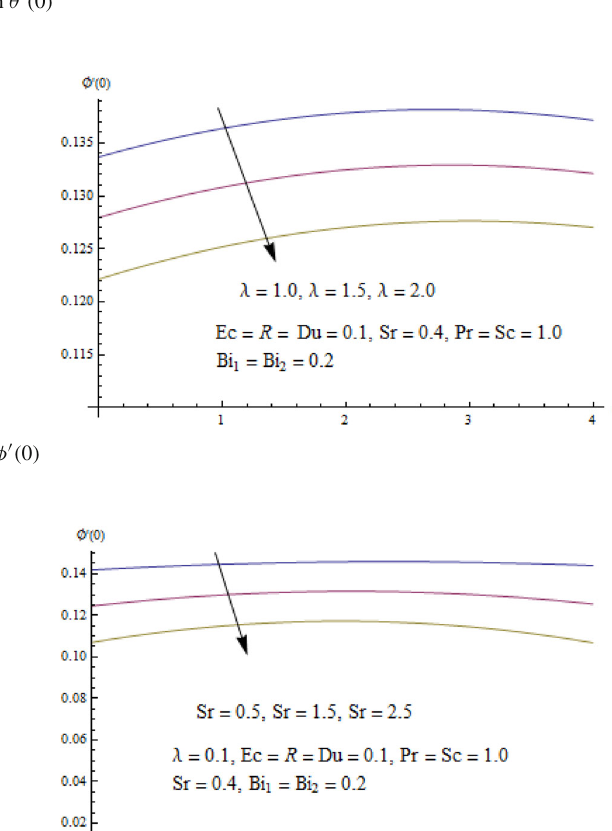
Fig. 30 Impact of Sr on φ (cid:5) ( 0